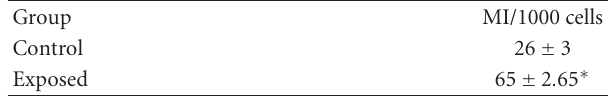
Table 4: Mitotic index in bone marrow cells of control newborn rats and those exposed to 50Hz and 0.5 mT MF for 30 days 24 h/day. Each value was expressed as mean of 10 rats ± standard